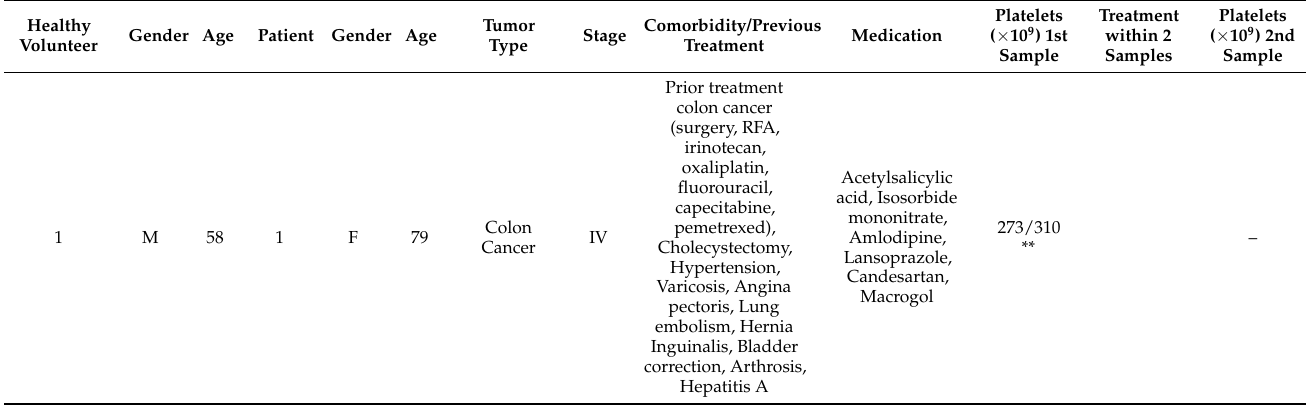
Varicosis, Angina pectoris,